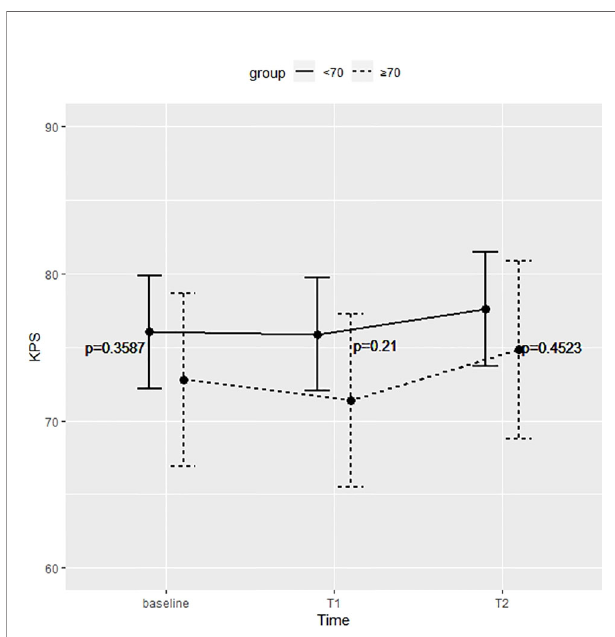
FIGURE 3 | Differences between the two groups were not signi fi cant at preoperative time (baseline), immediate postoperative (T1), and 5 months after surgery (T2).